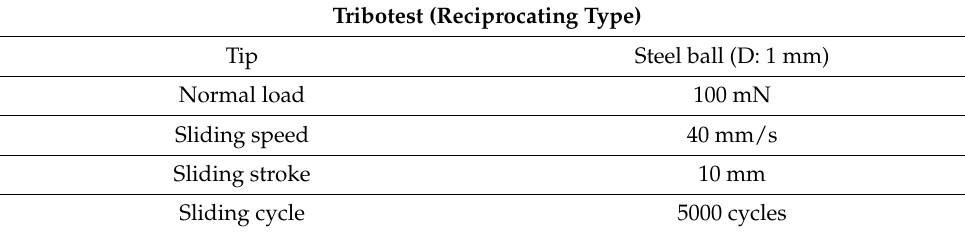
Table 3. Tribotest conditions.